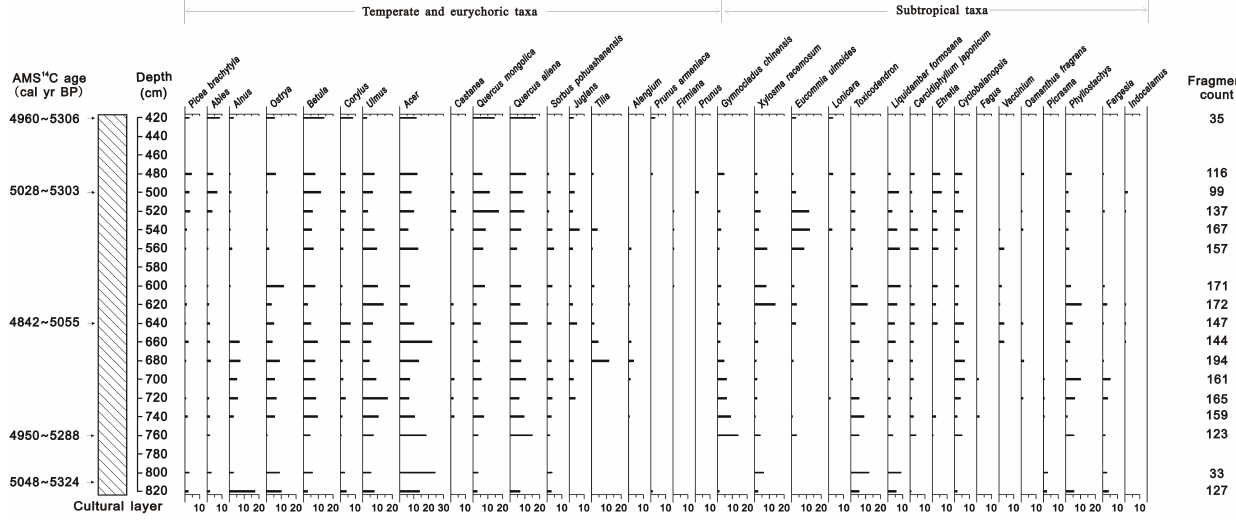
Fig. 4. The abundance ratio of fossil charcoal from the Dadiwan section.